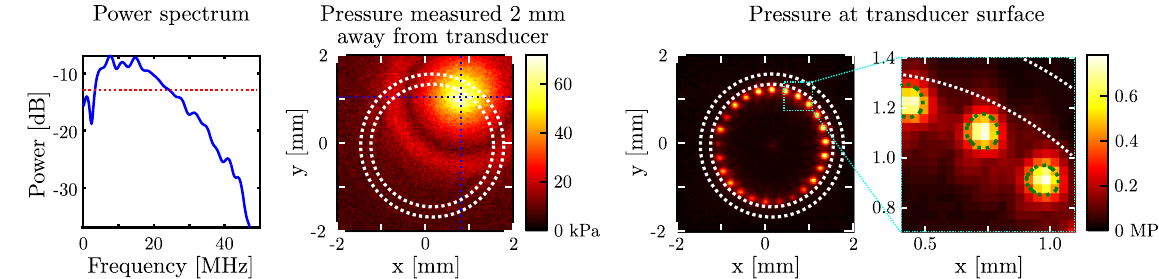
Figure 2. Left: Power spectrum (relative to 1 MPa) of the acoustic field transmitted by the optically absorbing coating, measured at a distance of 2 mm in front of the illuminated area. The dotted red line indicates the − 6 dB level used to measure the bandwidth. Middle: Peak acoustic pressure measured across a plane placed 2 mm away from the distal fibre bundle end. The dotted blue lines indicate the location of the illuminated area on the coating; the inner and outer dotted white circles delineate the ultrasound-generating aperture and outer edge of the fiber bundle, respectively. Right: Compound image of the peak acoustic pressures, measured at the surface of the distal end of the fibre bundle, for 25 different acoustical source locations. The dotted green contours indicate, for each source position, the full-width-at-half-maximum (FWHM) of the acoustic pressure and are representative of the size of the acoustical sources.